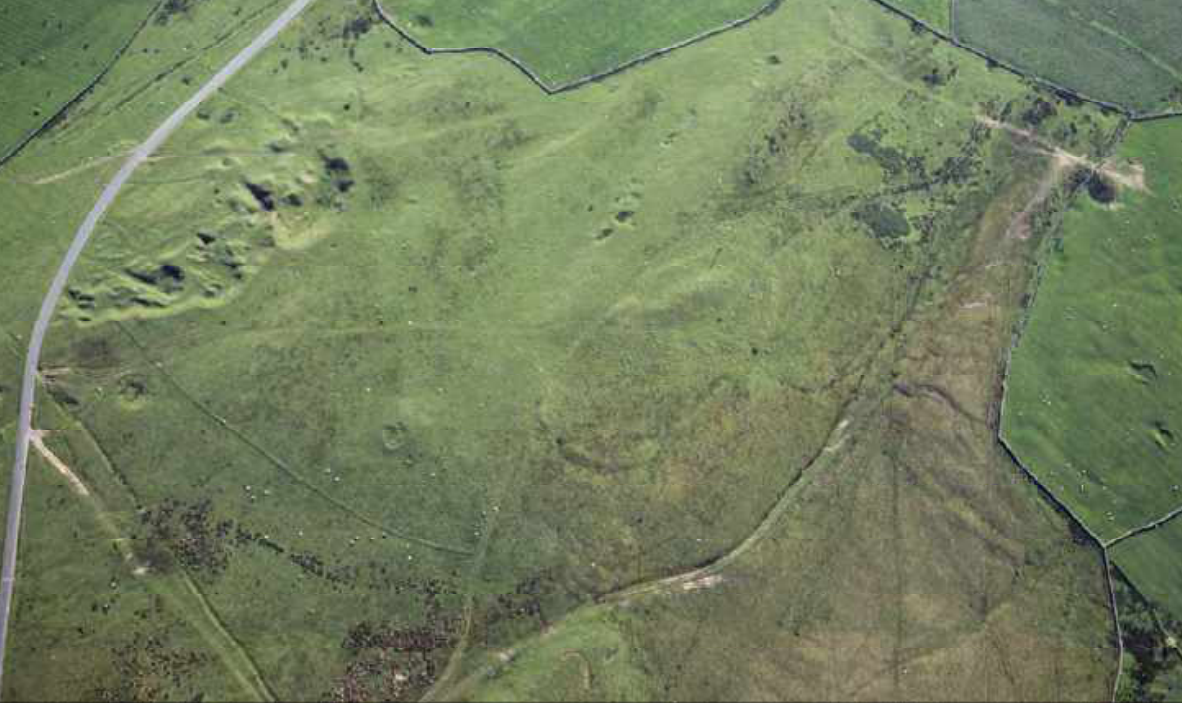
Fig 2.7 A possible Neolithic causewayed enclosure at Green How, Aughertree Fell, Cumbria (English